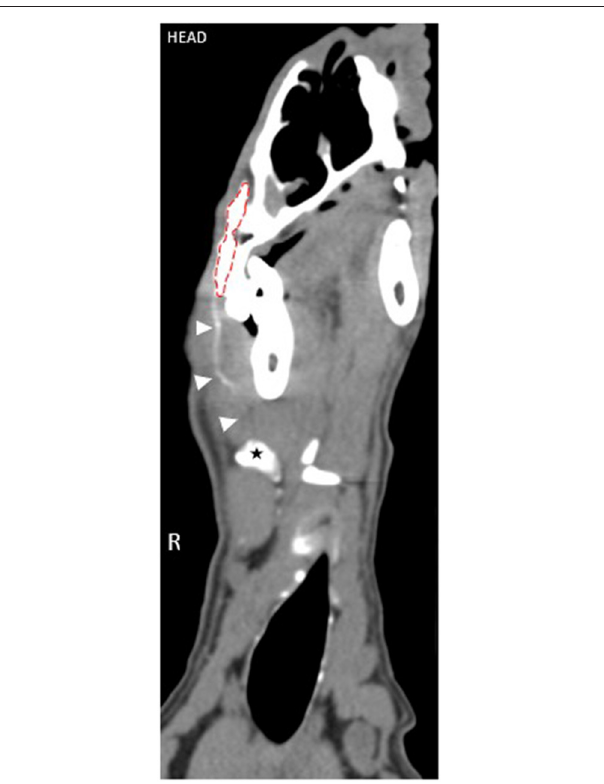
node at 7 days p.i. in all dogs. By 10 days p.i. 5/6 dogs had FIGURE 2 | Cross-sectional CTL reformatted image in an obliqued dorsal